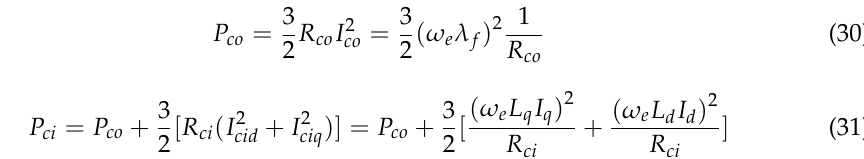
loss versus the motor speed (frequency), and then determine the no-load equivalent